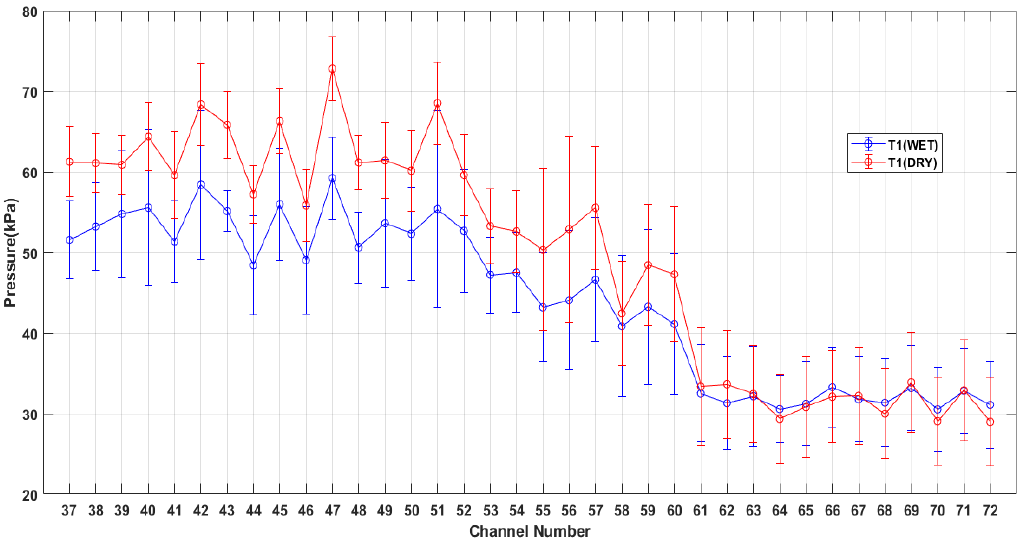
Figure 22. Peak Pressure of Dry Condition & Wet Condition of SWAY (T1).